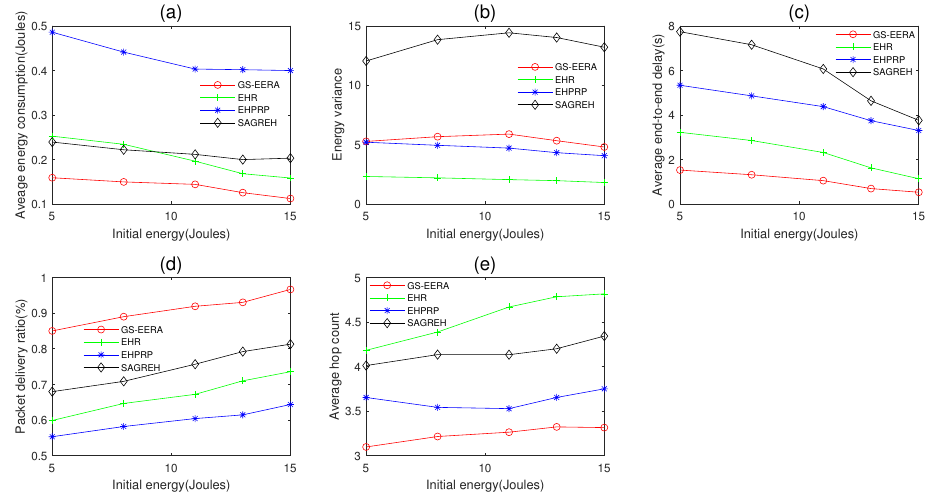
Figure 11. The impact of initial energy on ( a ) average energy consumption, ( b ) energy variance, ( c ) average end-to-end delay, ( d ) packet delivery ratio and ( e ) average hop